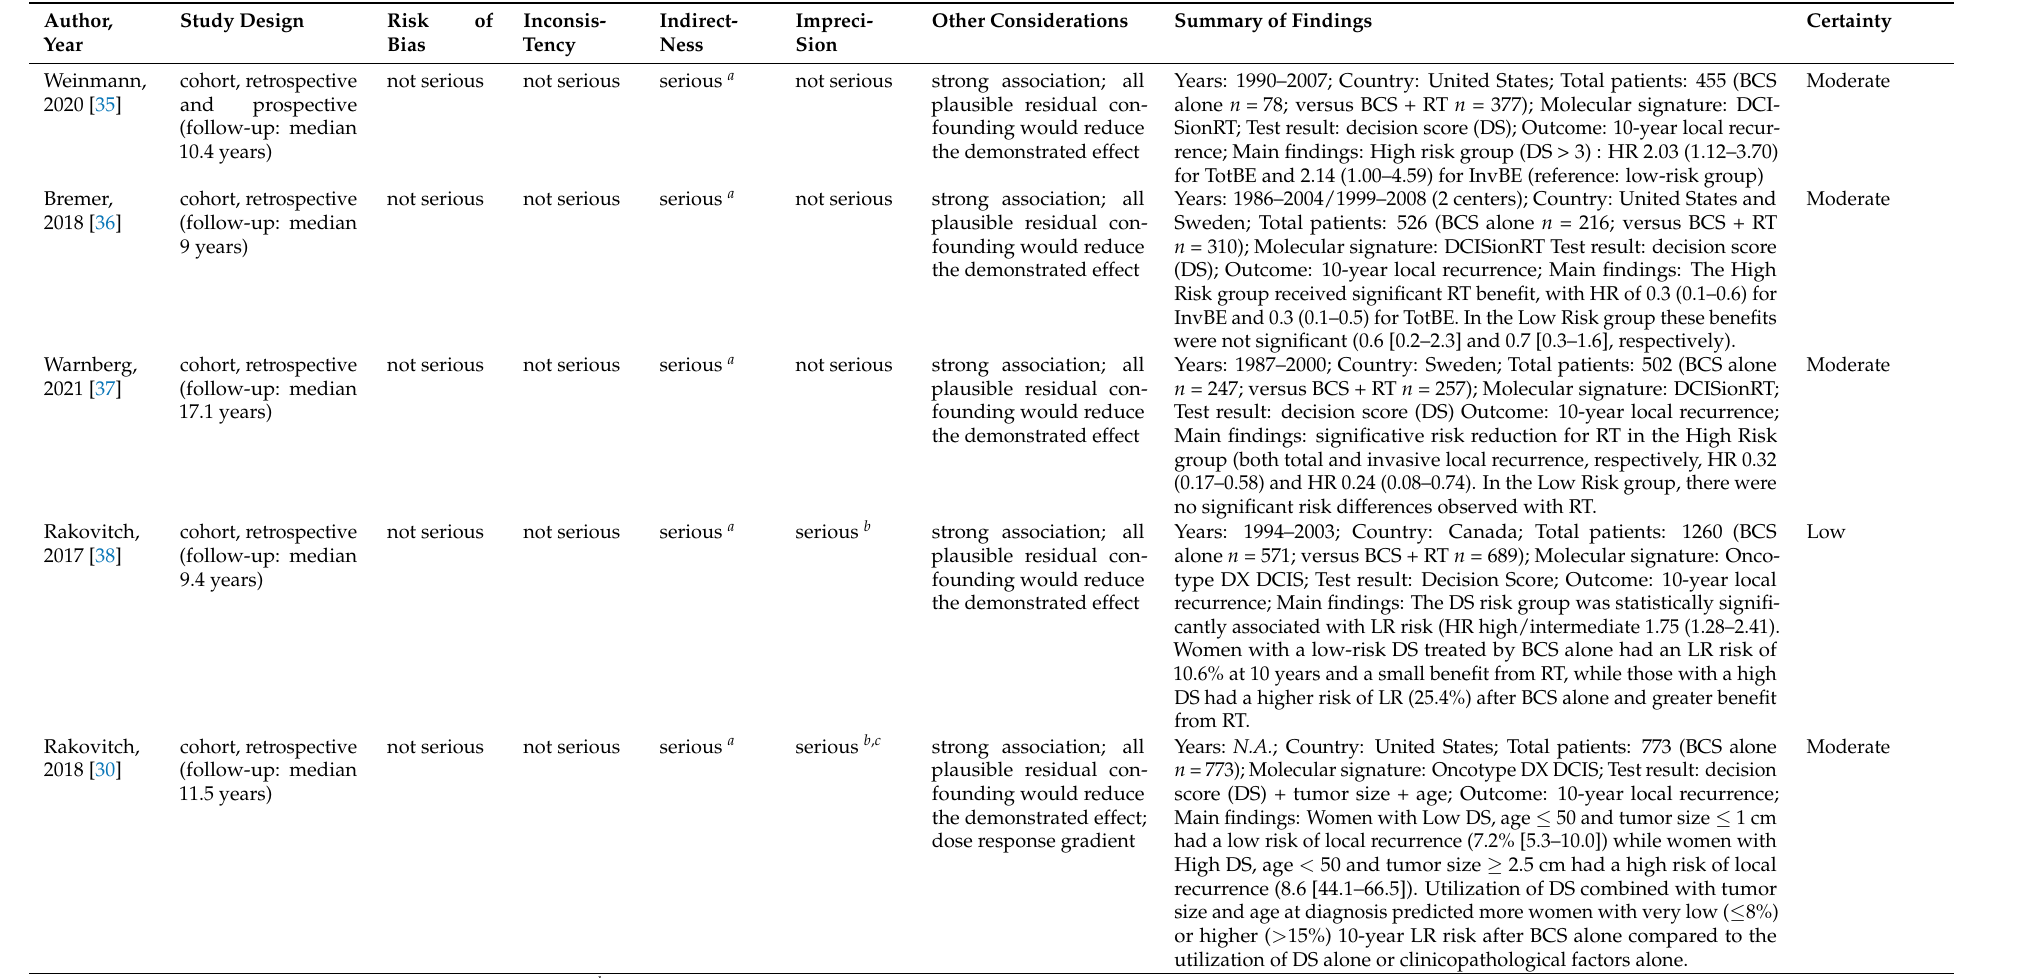
Table 1. Summary of included studies with GRADE rating of the certainty of